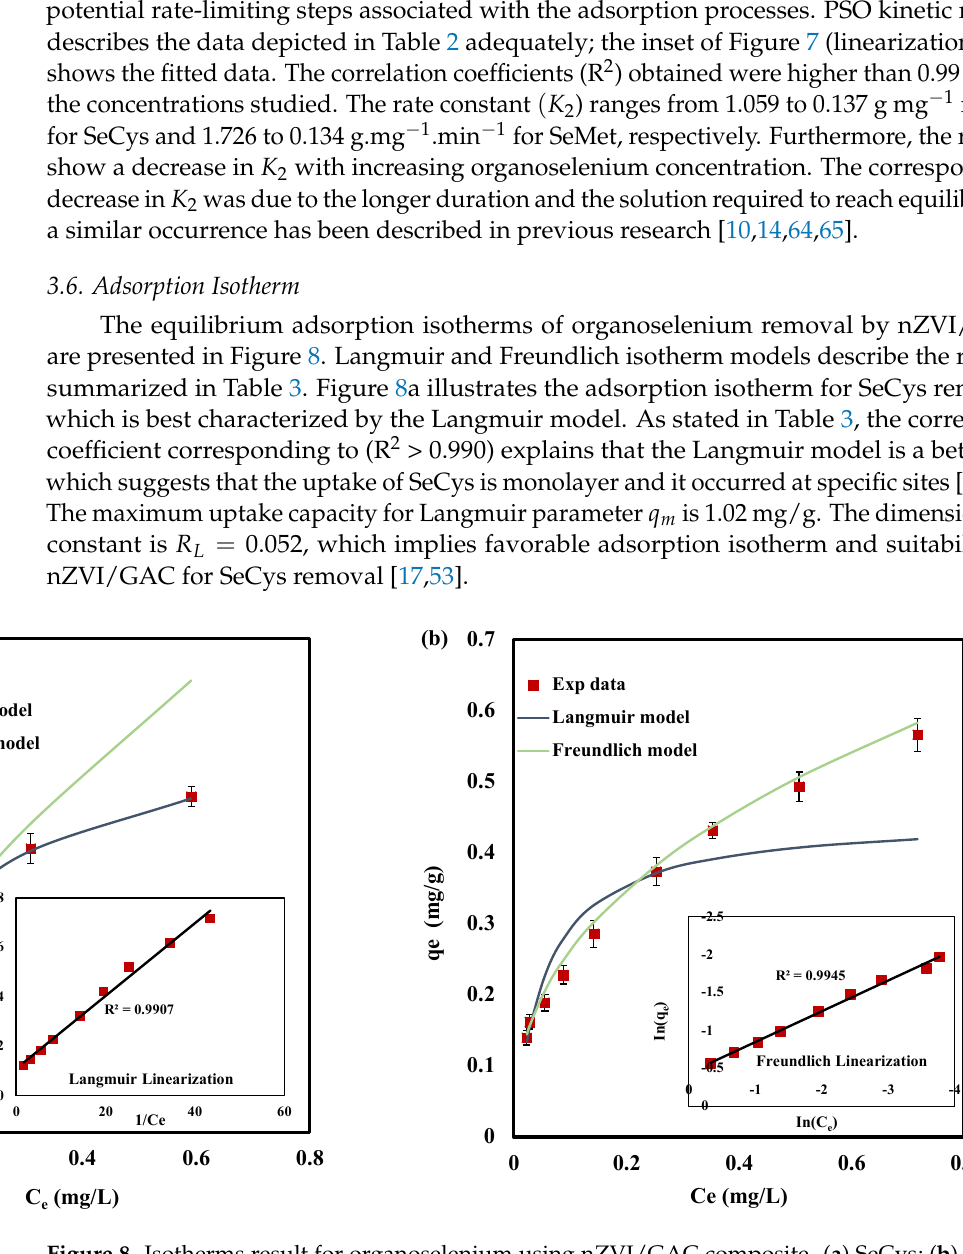
Figure 8. Isotherms result for organoselenium using nZVI/GAC composite. ( a ) SeCys; ( b ) SeMet. (The solid lines illustrate model fits; inset shows linearization fits.) Contact time: 24 h, pH 7.0, at 25 °C. Table 3. Adsorption isotherm parameters for organoselenium removal.